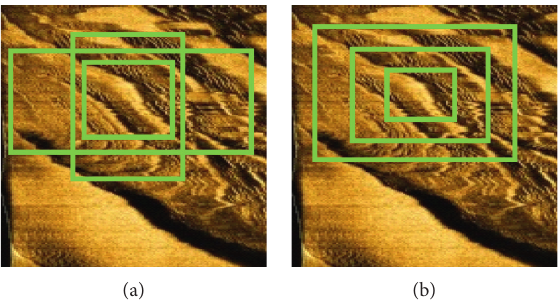
Figure 4: An example of the range of action of a priori box on a substrate texture